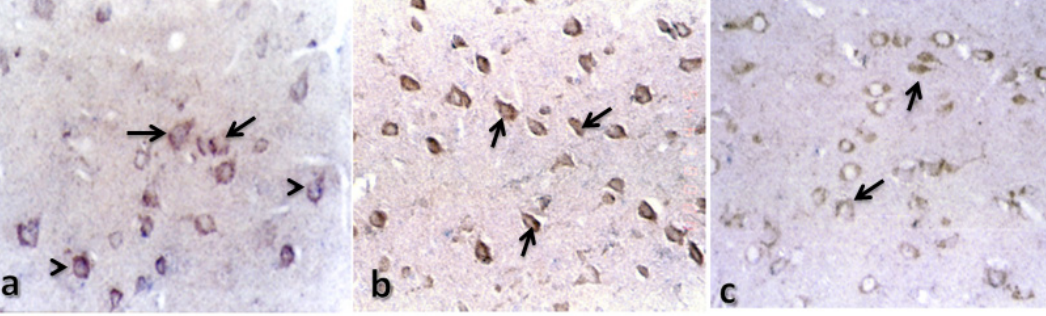
Figure 5. Effect of TBI in immunoreactivity of cathepsin B and CC in motor cortex. Representative micrographs showing the changes in the immunoreactivity of cathepsin B (brown) and CC (purple) of rats killed at 24 ( a ), 48 ( b ) or 72 ( c ) h after TBI. Cathepsin B was detected in the brains of control rats, and the expression level increased 24 h after TBI and decreased after 72 h. CC was only detected after TBI. Magnification: 20×. Arrows indicate cathepsin B staining, and arrowheads indicate cystatin C